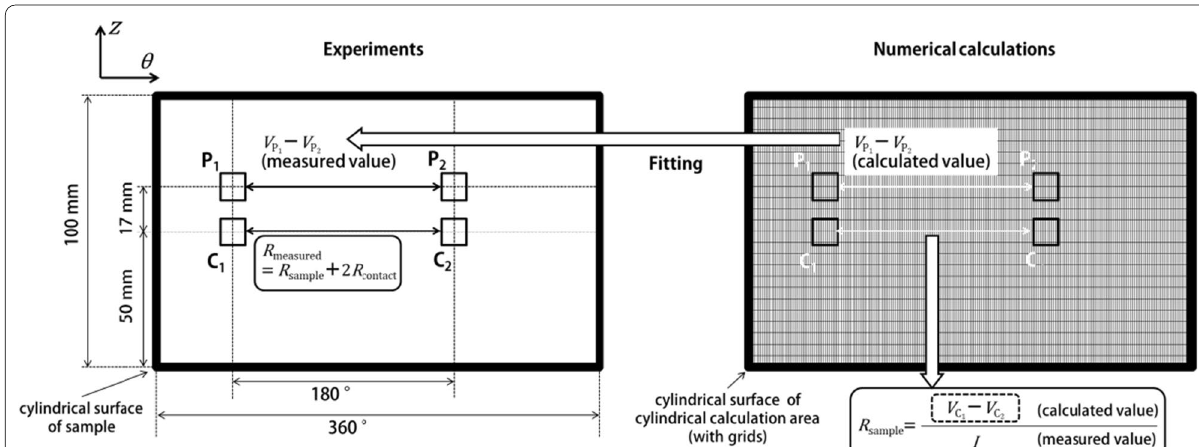
Fig. 6 Estimation of resistance between current electrodes. The coordinates z and θ are as defined in Fig. 2a. C 1 and C 2 are current electrodes, , V C and P 1 and P 2 are potential electrodes. V C , V P , and V P are electrical potential at C 1 , C 2 , P 1 , and P 2 . R measured , R sample , and R contact are, respectively, 1 2 1 2 the measured resistance between the current electrodes, the sample resistance between the current electrodes, and the contact resistance at the current electrodes. I is measured current. The left diagram depicts the measurement area (i.e. the sample’s side surface), and the right diagram represents the numerical model of the measurement area with its calculation grids. Performing numerical calculations under various sample resistivities searched for a potential distribution that mostly explains the observed V P – V P . The calculations assumed the sample to have a 1 2 homogeneous resistivity structure. V C – V C is extracted from the determined potential distribution, and used to obtain R sample by dividing it by 1 2